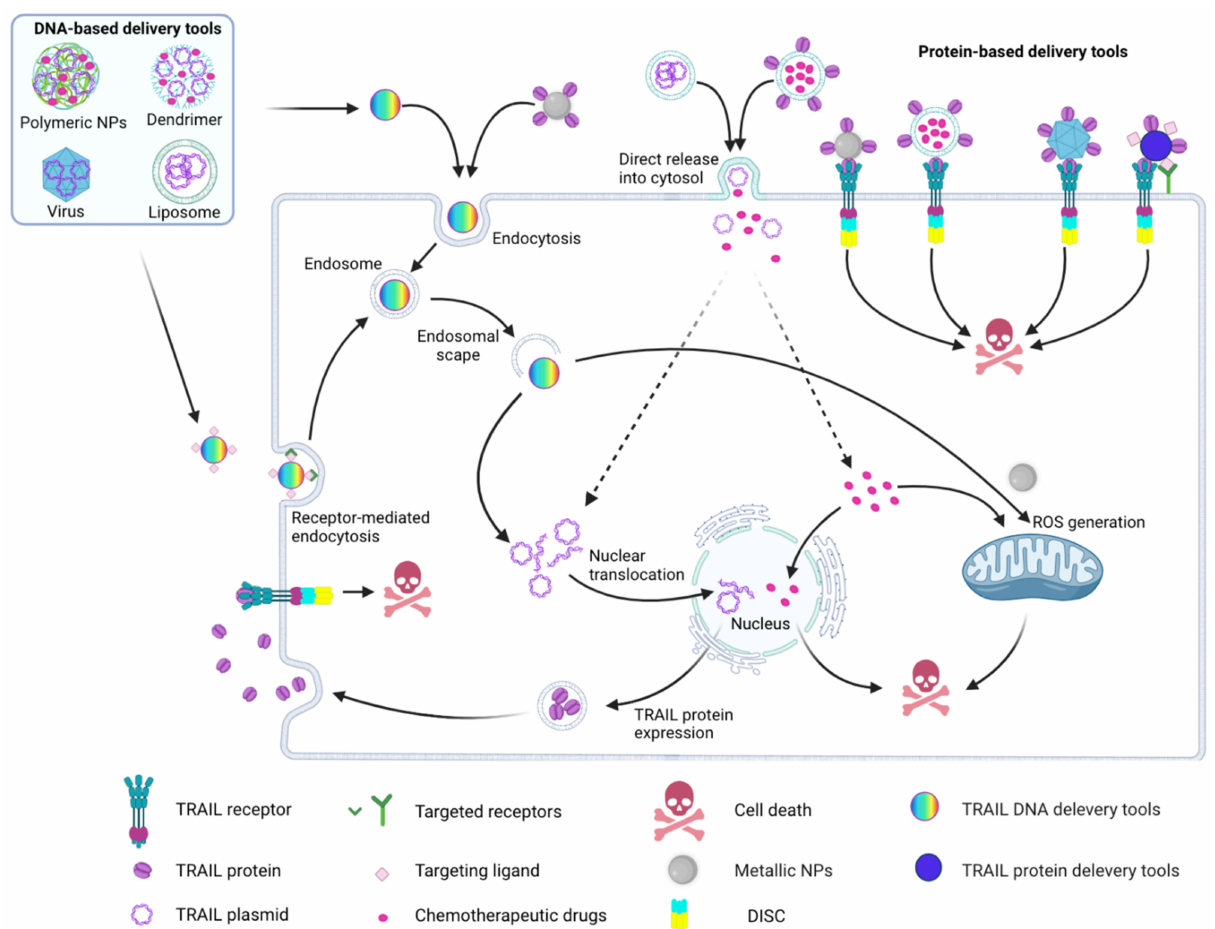
Figure 3. Schematic representation of using nanoparticles to improve TRAIL efficacy. TRAIL DNA- based delivery tools: Uptake by tumor cells via either passive- or active (receptor-mediated) endocy- tosis. The endocytosed NPs escape from the endosome and release the encapsulated TRAIL gene into the cytosol, which then translocates to the nucleus. After transcription and translation, soluble TRAIL is released into the tumor microenvironment, where it can interact with its receptors (death receptor (DR)4 and 5 to induce apoptosis. Alternatively, TRAIL gene-encapsulating liposomes can fuse with the cell membrane and directly release the TRAIL gene into the cytosol. Dendrimers and polymeric NPs can co-deliver TRAIL gene and chemotherapeutic reagents, resulting in DNA damage thus amplifying the TRAIL-induced cell death signals. The figure was generated with